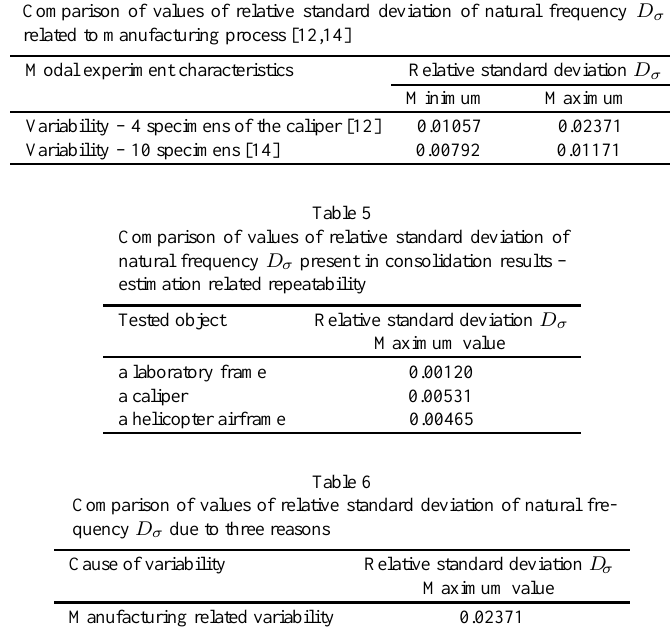
Table 4 Comparison of values of relative standard deviation of natural frequency D σ